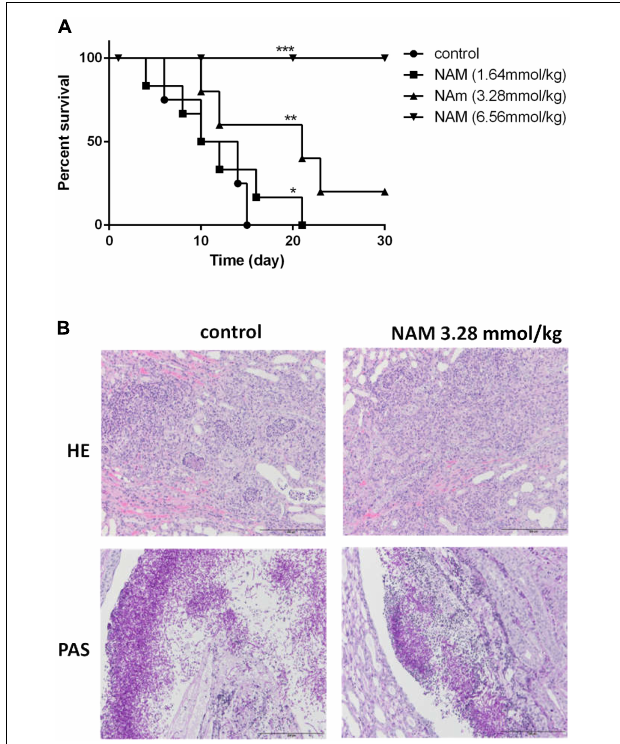
FIGURE 3 | (A) Survival curves of BALB/c mice with disseminated candidiasis treated by NAM. The mice were infected with 5 × 10 6 CFU C. albicans SC5314 in 200 µ l sterile saline intravenously and monitored for 30 days ( n = 8 per group). (B) Inflammatory responses and C. albicans colonization in mouse kidney ( × 200 magnification). Representative HE (hematoxylin and eosin) and PAS (periodic acid-Schiff) staining of kidneys from BALB/c mice infected with 5 × 10 6 CFU C. albicans SC5314 at day 6 were used to detect the inflammatory cells influx and the extent of tissue necrosis or hyphae invasion. ∗ P < 0.05; ∗∗ P < 0.01, ∗∗∗ P < 0.0005 as compared to the control